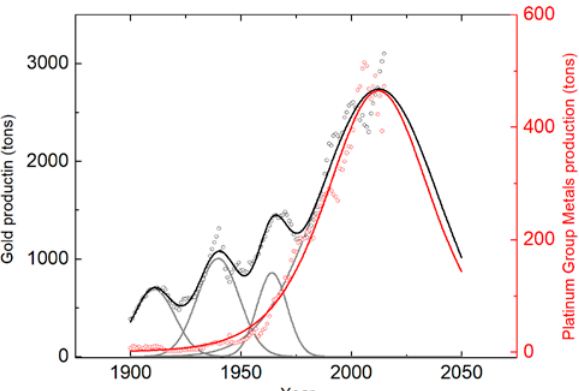
Figure 1. Hubbert peaks of Gold (black) and Platinum Group Met- als (red): past production and future